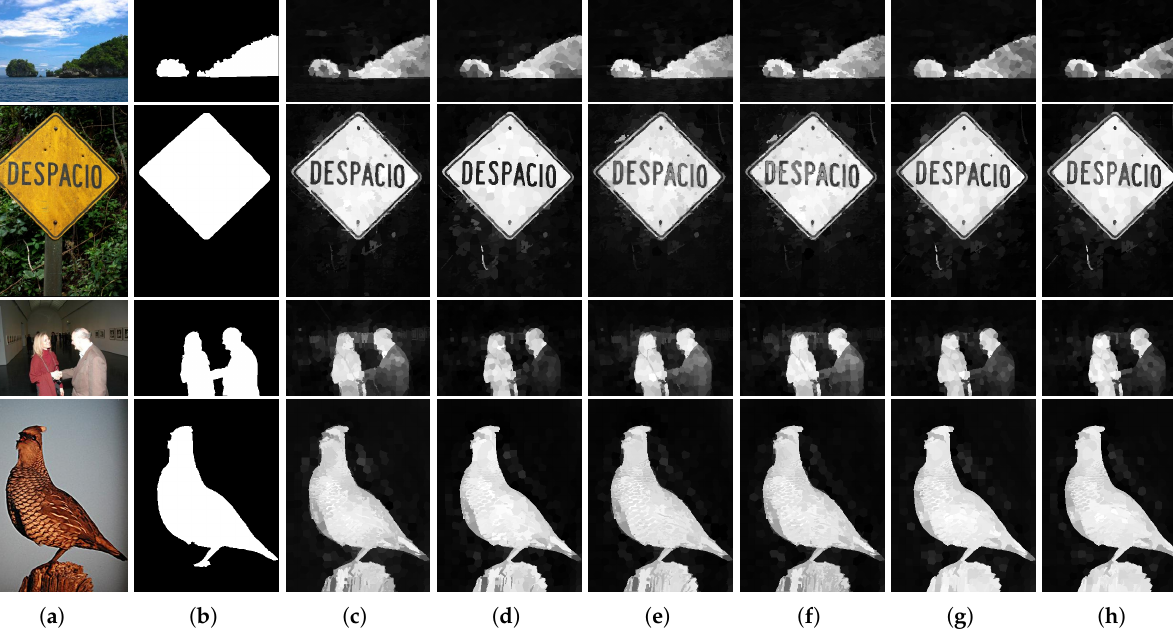
Figure 7. Visual comparison for HDCT [48]. ( a ) Input images; ( b ) ground truth; ( c ) results of HDCT; ( d ) BF; ( e ) ODOG; ( f ) LODOG; ( g ) BF+ODOG; ( h )